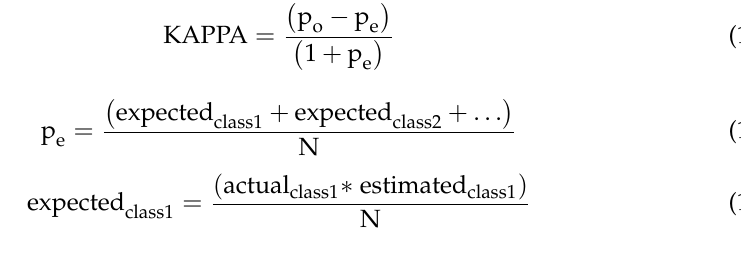
Figure 9. Višegrad Dam aquatic site ( top ) and tyre graveyard in Kuwait ( bottom ) as the original ANN classification ( left ) and result after the decision tree filtering ( right ). 3.2. Accuracy Assessment The accuracy statistics for the developed classifier are shown in Table 5, with the Precision and Recall alongside F1-score calculated for each class. To improve the robust- ness of the assessment, an additional five validation sites (shown at the bottom of Table A1) were added that were not included in the iterative model training/validation process and that statistics recalculated; shown in Table 6. In Table 5, all the Precision values except Aqueous Deposits are high, greater than 0.8, equating to the classifier being correct more than 80% of the time. When the addition validation sites are included, Table 6, all classes remain high (greater than 0.7) except for the Aqueous Deposits, Building and Plastic. These classes have a highly variable spectral shape across the training/validation datasets and so a single class is a generalization of that variability. The Plastic class was strongly influenced by the inclusion of sites such as Haiti with a windrow that was not detected; see Figure 10. The windrow can see be visible seen in the stretched pseudo-colour composite, Figure 10 (bottom left), but is not visible in the unstretched Sentinel-2 pseudo-colour composite or backscatter image. All the Recall values are also high; the classifier can capture most of the positive pre- dictions. As a result, the F1-scores are high except for those classes with a low Precision, i.e., both Precision and Recall are high. This behaviour is evident in both Tables 5 and 6, where the classes with low Precision scores have lower F1-scores. In terms of the overall statistics, the average Precision and KAPPA coefficient were calculated for the aggregate of all the classes, with both also presenting high values of 95% and 0.86 in Table 5. For Table 6, the aggregate Precision has dropped to 0.820 but the KAPPA has increased to 0.897. KAPPA is better at assessing imbalanced class problems, and a value of greater than 0.81 is classified as “Almost Prefect” [56].